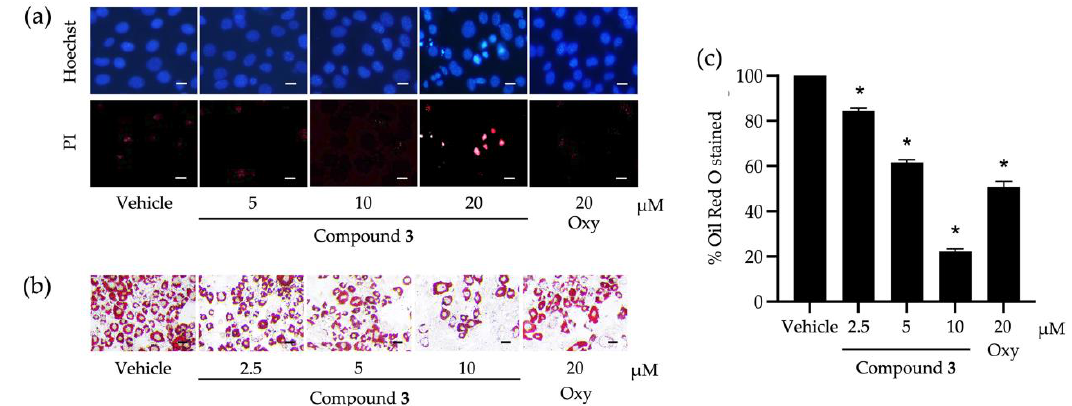
Figure 3. Roles of compound 3 derived from Dendrobium heterocarpum in the viability and lipid stor- age of adipocytic cells. Dead 3T3-L1 cells caused by compound 3 tested at different concentrations (5, 10, and 20 µM) were confirmed by a nuclear staining method using Hoechst 33342 (Hoechst) and propidium iodide (PI) ( a ). The impact of compound 3 at non-cytotoxic concentrations (2.5, 5, and 10 µM) on the lipid storage of 3T3-L1 cells was assessed using the Oil Red O staining method ( b ); scale bars = 10 µm. The percentage of Oil Red O-stained was computed after the normalization with the total cellular protein ( c ). The graphical results demonstrate means ± SDs derived from three inde- pendent experiments. The asterisk (*) represents a statistical difference at p < 0.05 between the treat- ment and untreated vehicle control made of 0.5% ( v / v ) dimethyl sulfoxide, assessed by one-way ANOVA with Tukey’s post hoc test. A positive control made of 20 μM of oxyresveratrol (Oxy) might be included in some experiments.